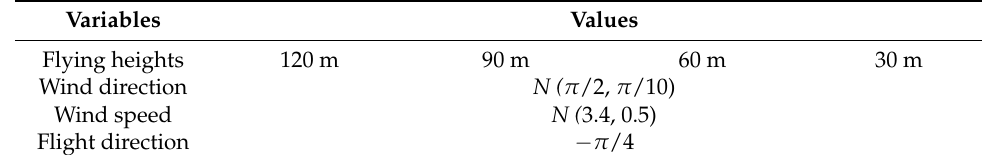
Table 10. Parameters for different flying heights.